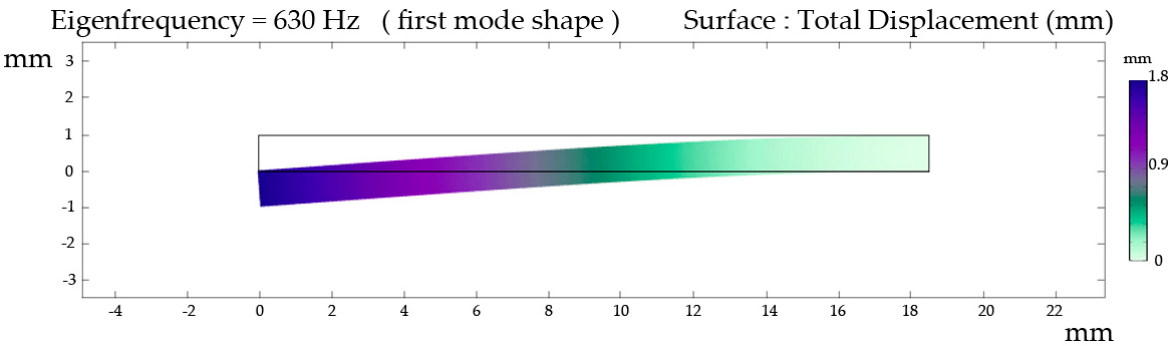
Figure 12. First mode shape of piezoelectric beam I.